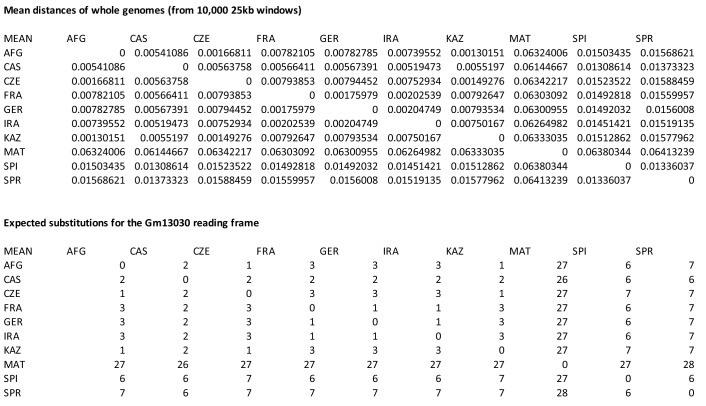
Distance matrices for whole genome comparisons and expected numbers of substitutions for Gm13030.